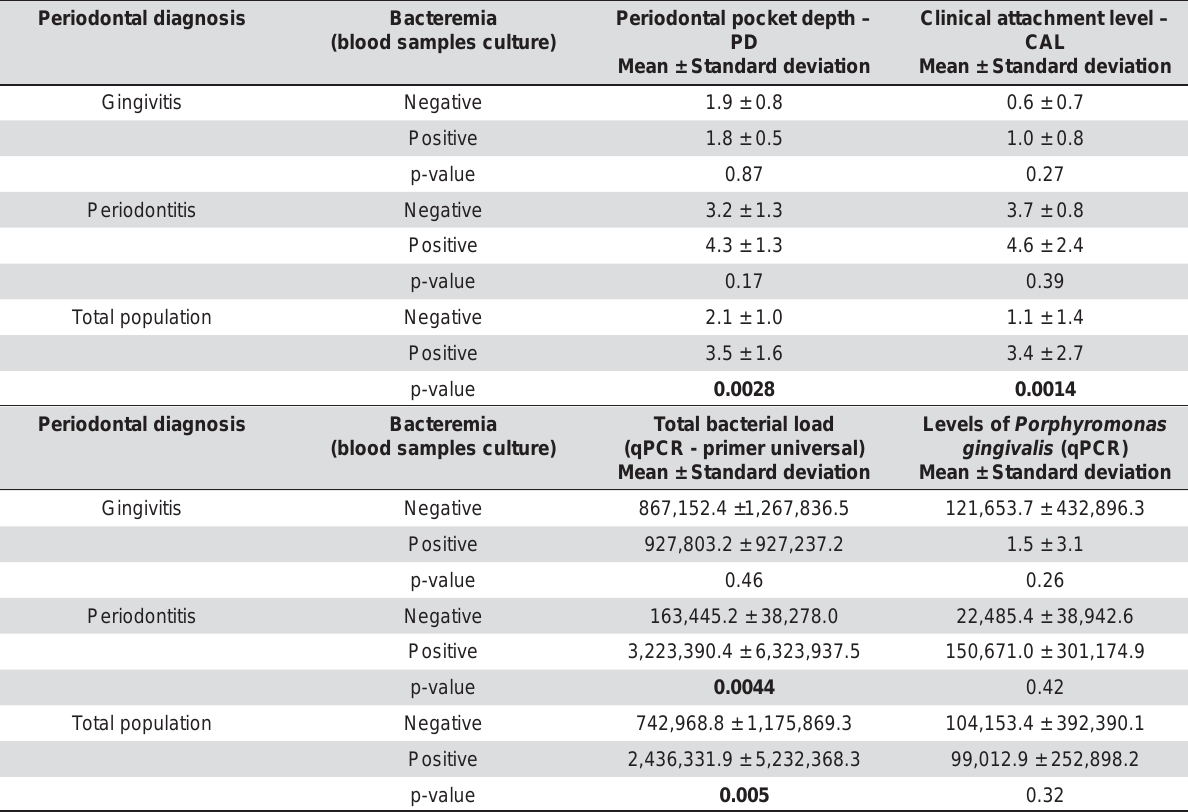
Table 4- Comparative mean periodontal clinical (periodontal pocket depth – PD and clinical attachment level – CAL) and microbiological parameters (total bacterial load and levels of P. gingivalis in subgingival samples), between positive and negative bacteremia individuals, according to periodontal diagnosis. Data for the entire study population is also